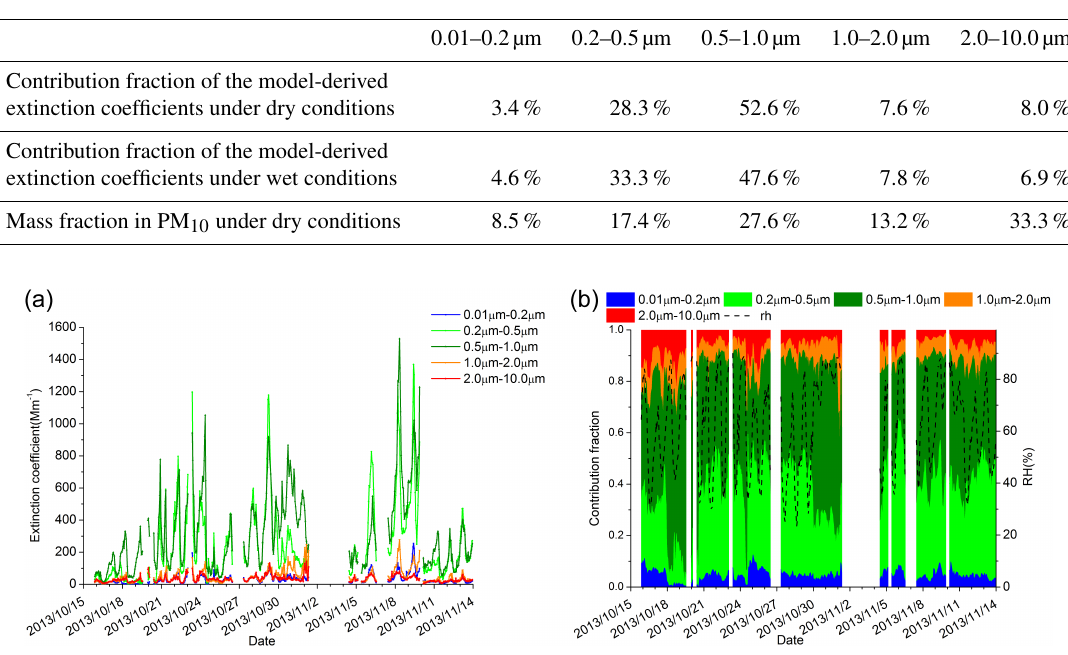
Figure 9. Time series (a) and the relative contributing fraction (b) of different size segments to the wet aerosol extinction coefficient.